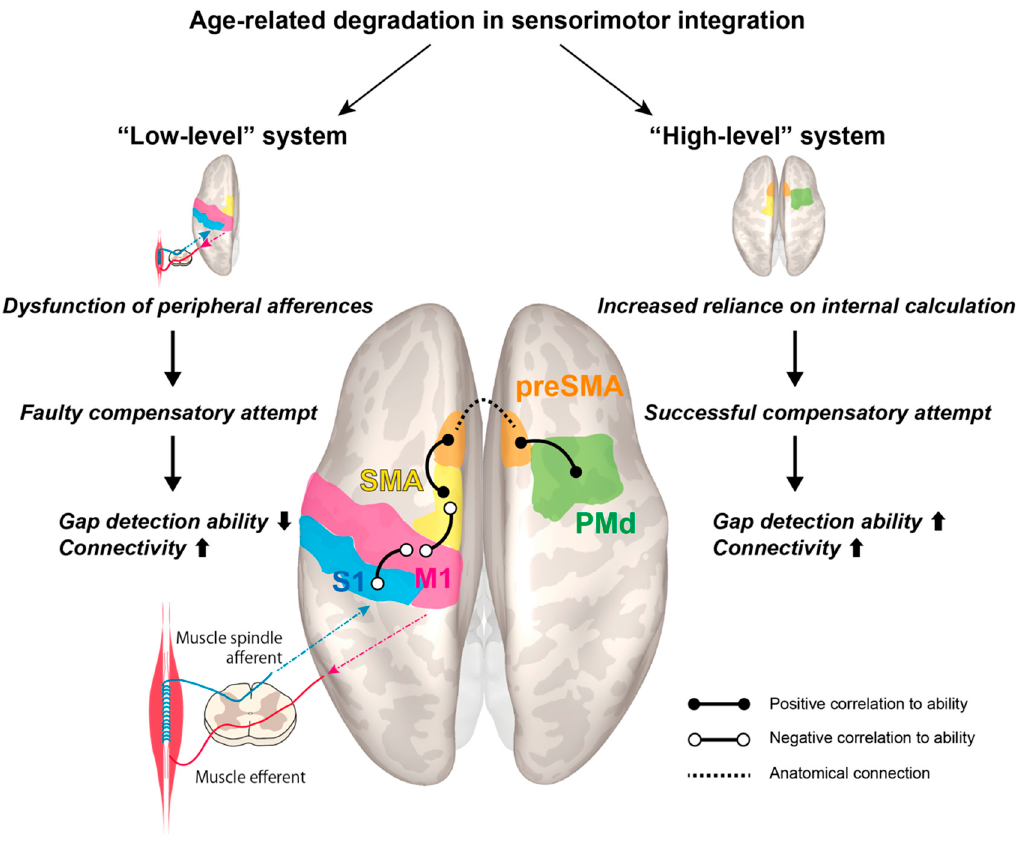
Figure 5. Proposed model for cortical reorganization accompanying age-related decline in sensorimotor